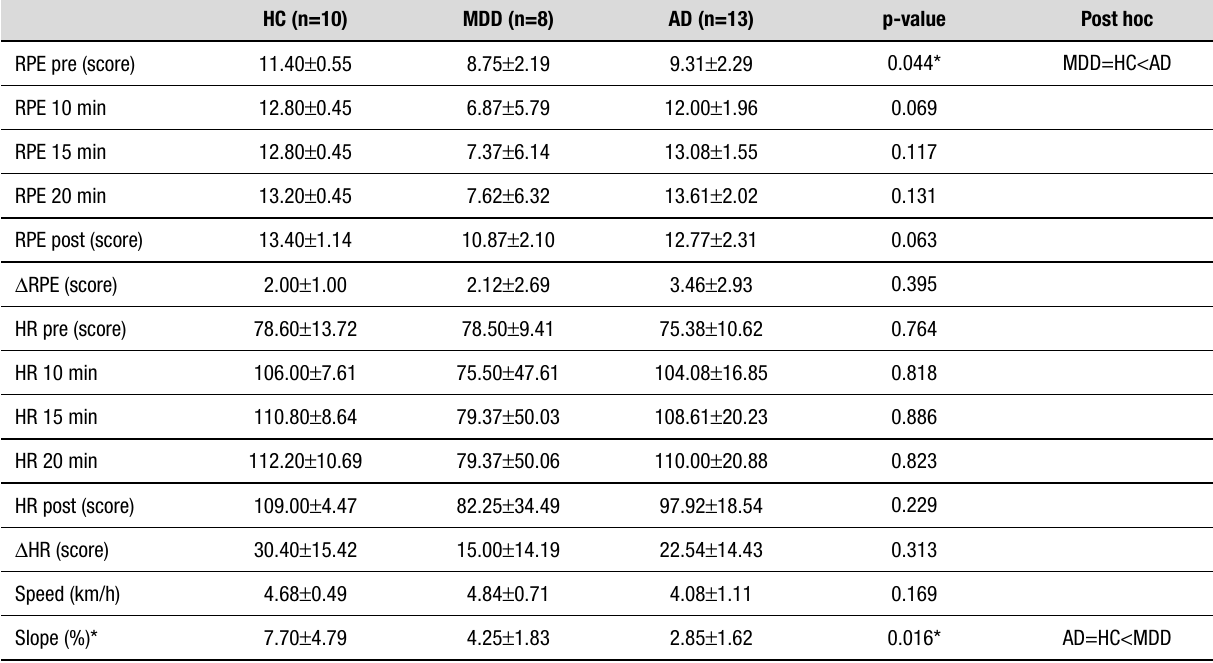
Table 2. Characteristics of the sample during acute exercise and changes (post–pre) with physical stressor.